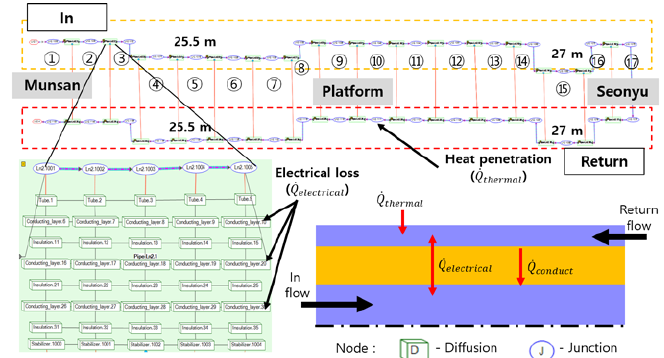
Figure 10. Expanded 1-D network model and heat balance diagram for the internal return path.